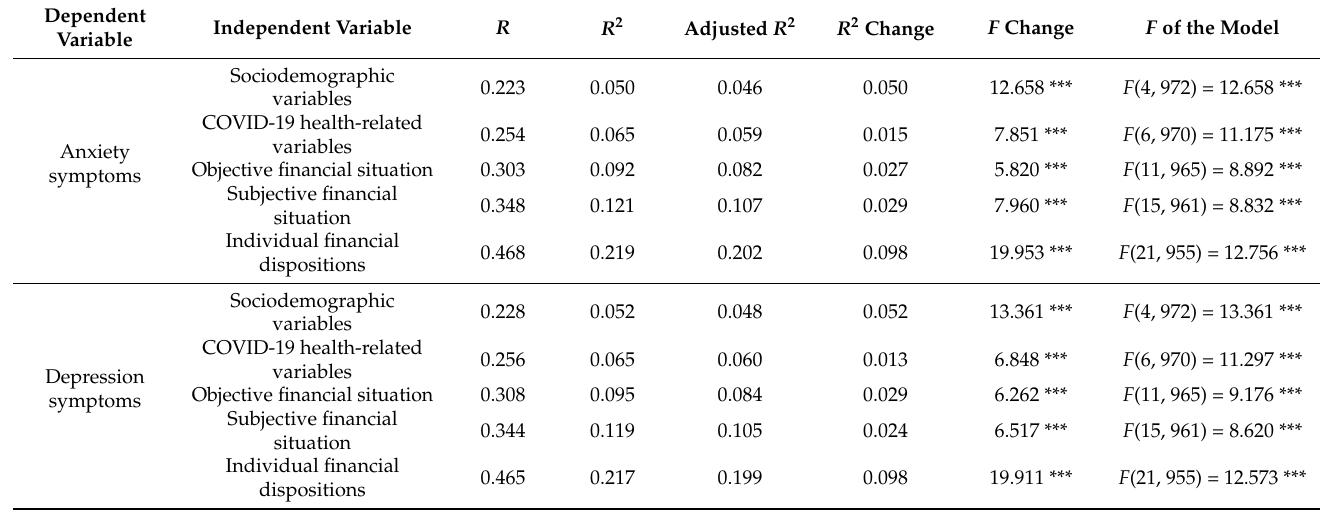
Table 2. Results of two hierarchical regression analyses predicting psychological distress from categories of